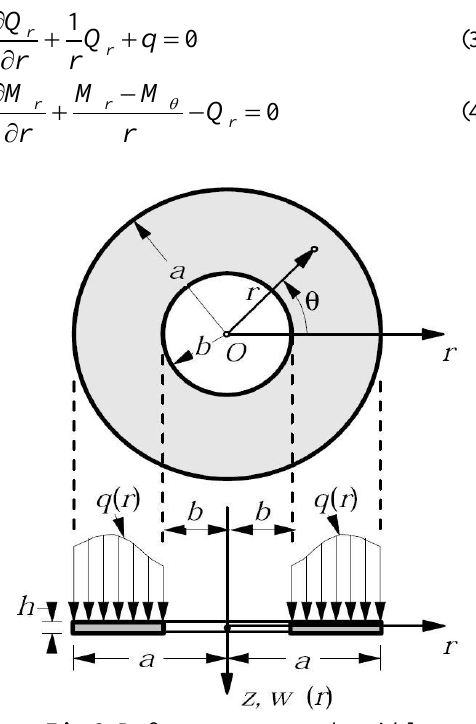
Fig. 2. Reference system and